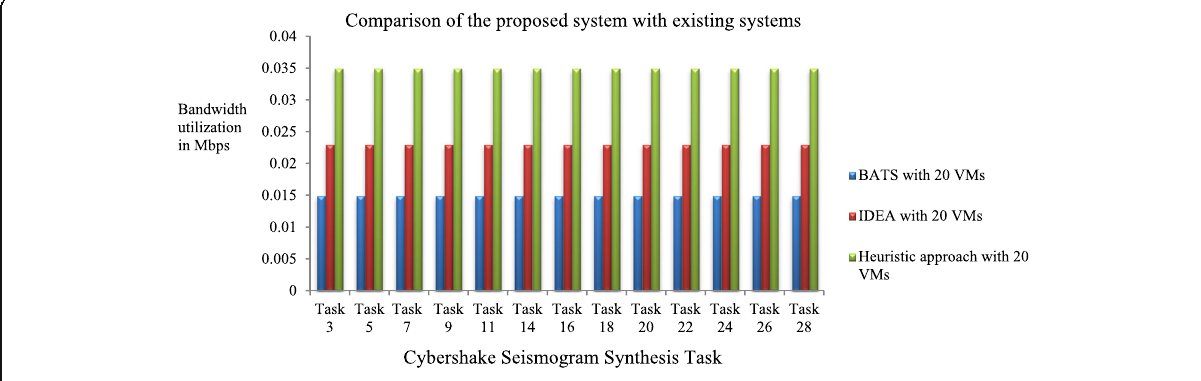
Fig. 14 Bandwidth comparisons for Cybershake